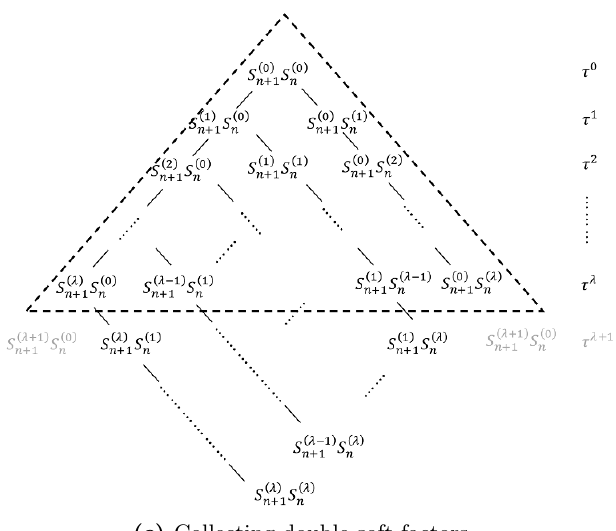
Figure 2. Deriving type A double soft from single soft theorems. The coordinate follows the Pascal triangle in (cid:12)gure 1. (a) First single soft expansion, in p , up to order O soft expansion, in q , also up to order O terms that cannot be derived from single soft theorems (e.g. the ones in gray). Therefore, only the terms in the dashed triangle can be incorporated into double soft theorems. The remaining terms would be discarded.